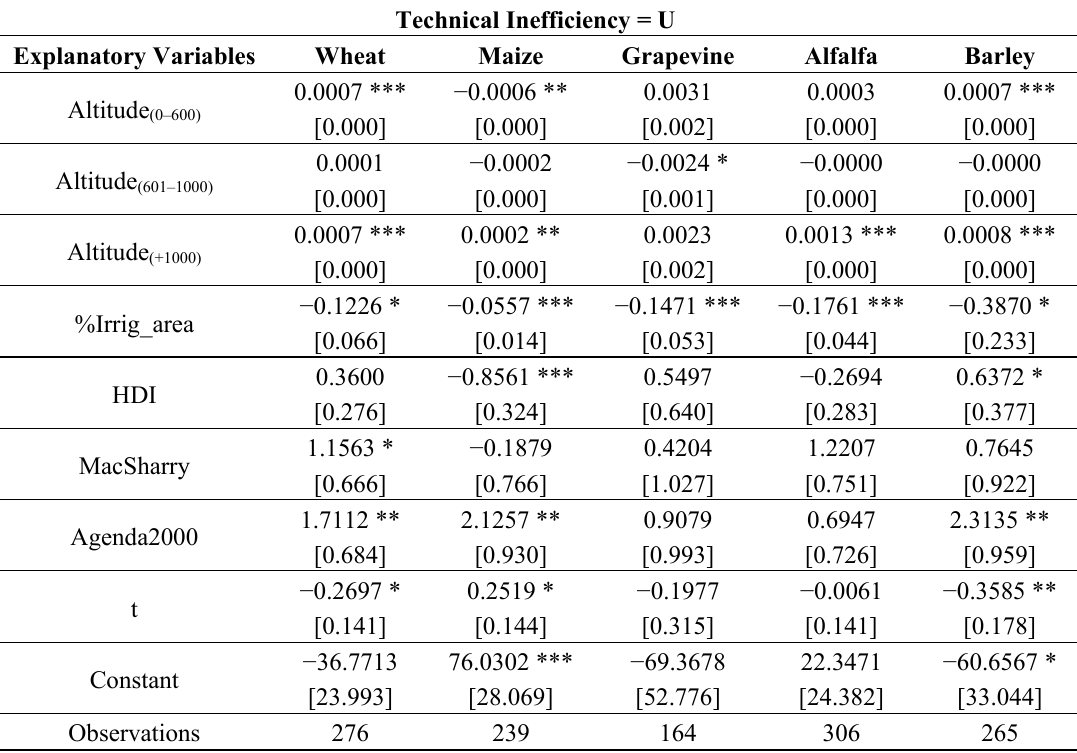
Table 4. Technical inefficiency model.